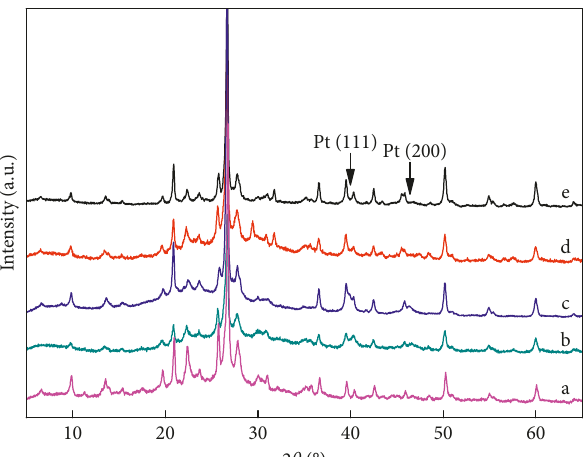
Figure 2: XRD patterns of the as-prepared catalysts: (a) MORn; (b) 1% Pt/MORn; (c) 1% Pt/MORn-H; (d) 1% Pt/MORn-OH; (e) 1% Pt/